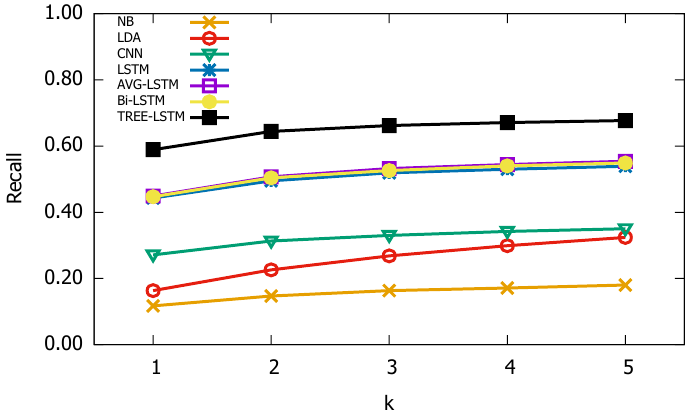
Figure 14. Recall values with recommended hashtags range from 1 to 5 in Twitter dataset.